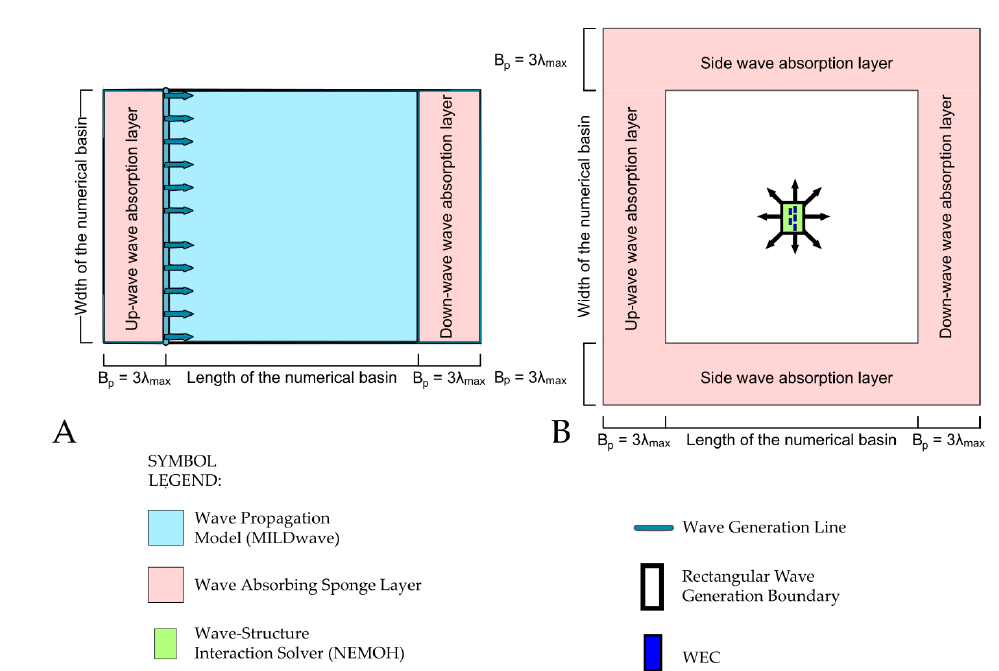
Figure 6. Schematic showing the coupling methodology domain with the MILDwave Empty Basin on the left and the coupled NEMOH-MILDwave perturbed wave run. SL indicates the sponge layer as in Section 2.3 and λ max is the simulated wavelength. ( A ) shows the Empty Basin set-up; ( B ) the coupled model run